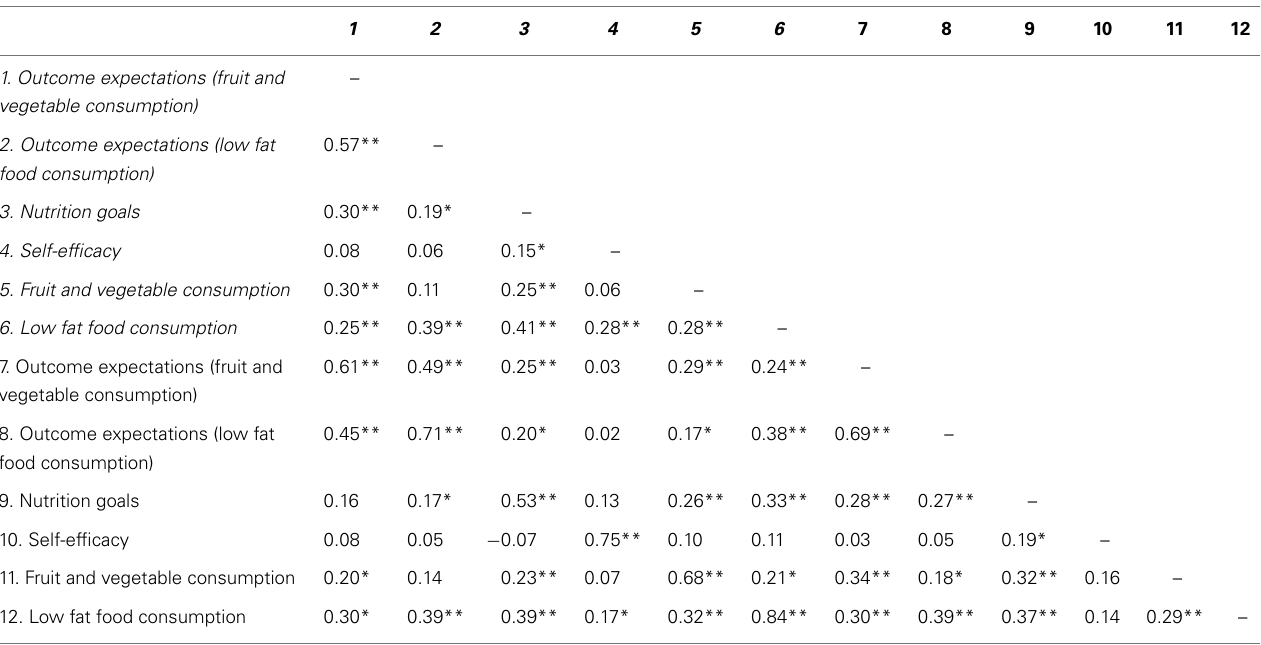
Table 3 | Bivariate correlations among all measured variables at baseline and follow-up